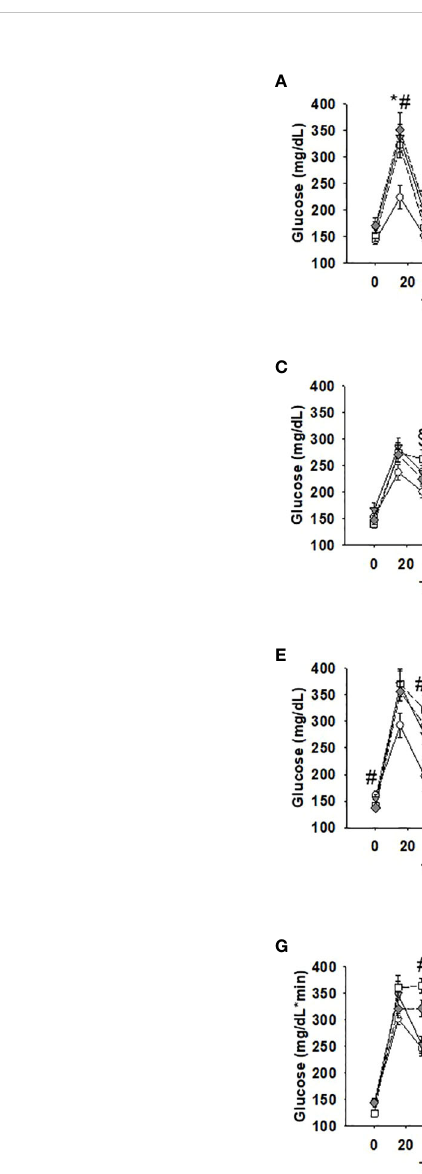
female offspring had lower lean mass compared to male offspring (Figure 2B, p = 0.022; Figure 2D, p = 0.008; and Figure 2F, p = 0.048). At 12 weeks of age, marginal sex effects were observed where female offspring exhibit a trend towards increased fat mass compared to male offspring (Figure 2G, p = 0.052) and male offspring exhibit a trend towards higher lean mass compared to female offspring (Figure 2H, p = 0.055). No interactions between sex and treatment were detected regarding offspring lean and fat mass